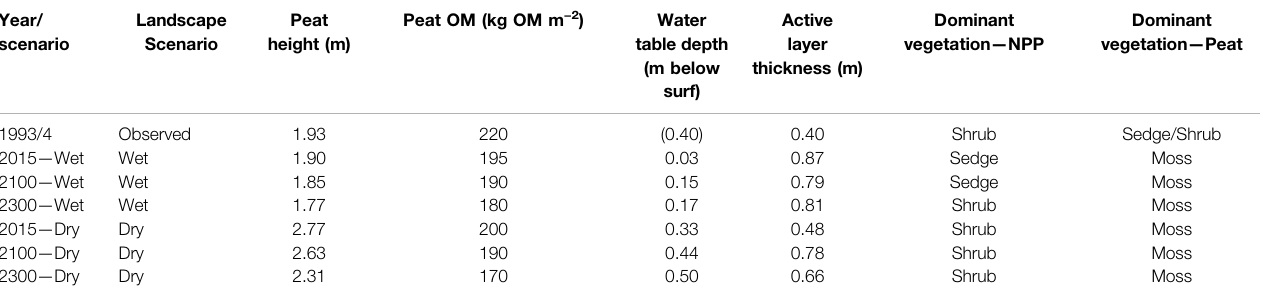
TABLE 2 | Field observations and model results for present day (2015: means of 2006 – 2015 CE) and future scenarios, including 2100 (means of 2091 – 2100 CE) and 2300 (means of 2291 – 2300 CE) for peat height, peat organic matter (OM) stocks, water table depth, maximum annual active layer thickness, and dominant vegetation